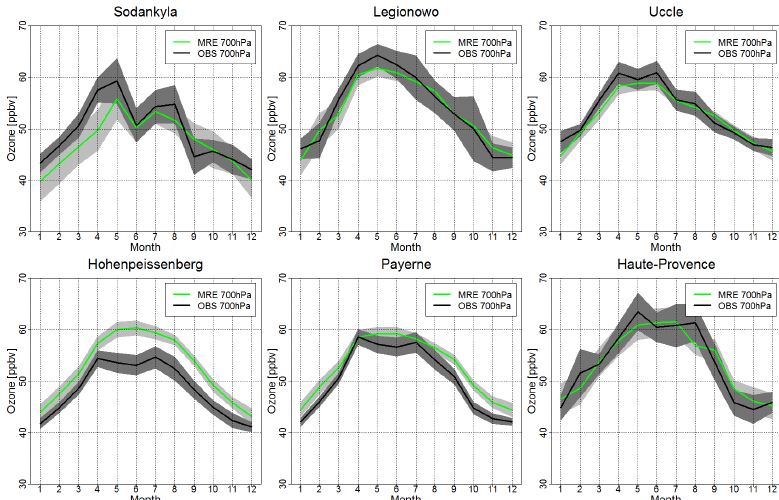
Figure 8. Mean 2003–2012 annual cycle of lower tropospheric ozone at 700hPa based on MRE (green line) and ozonesonde measure- ments (black line) at the stations of Sodankyla (67.4 ◦ N, 26.6 ◦ E), Legionowo (52.4 ◦ N, 20.9 ◦ E), Uccle (50.8 ◦ N, 4.3 ◦ E), Hohenpeissenberg (47.8 ◦ N, 11 ◦ E), Payerne (46.8 ◦ N, 6.9 ◦ E), and Haute-Provence (43.9 ◦ N, 5.7 ◦ E). The shading areas denote 95% confidence interval of the mean